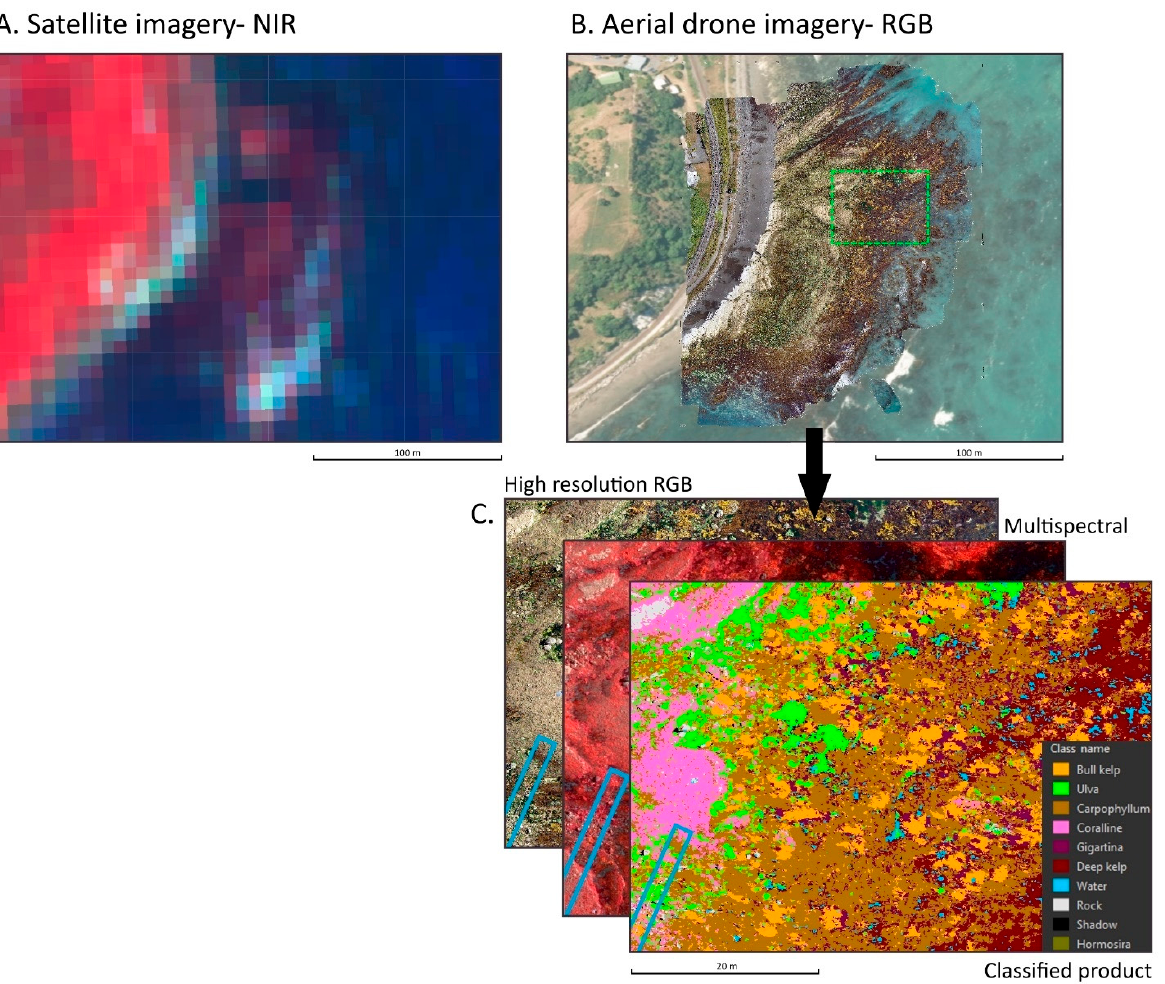
Figure 1. Relative view of Sentinel-2 satellite imagery ( A ) and small scale RGB imagery ( B ), including multiple data-layers (RGB, multispectral, and classified image) of the green-dashed rectangle ( C ). NIR bands from Sentinel-2 provide NDVI based detection of aquatic vegetation at a pixel resolution of 10 × 10 m ( A ) but lack the spatial resolution for species level detection. Aerial drone imagery provided RGB pixel resolution of c. 1 × 1 cm and multispectral pixel resolution of c. 2 × 2 cm.